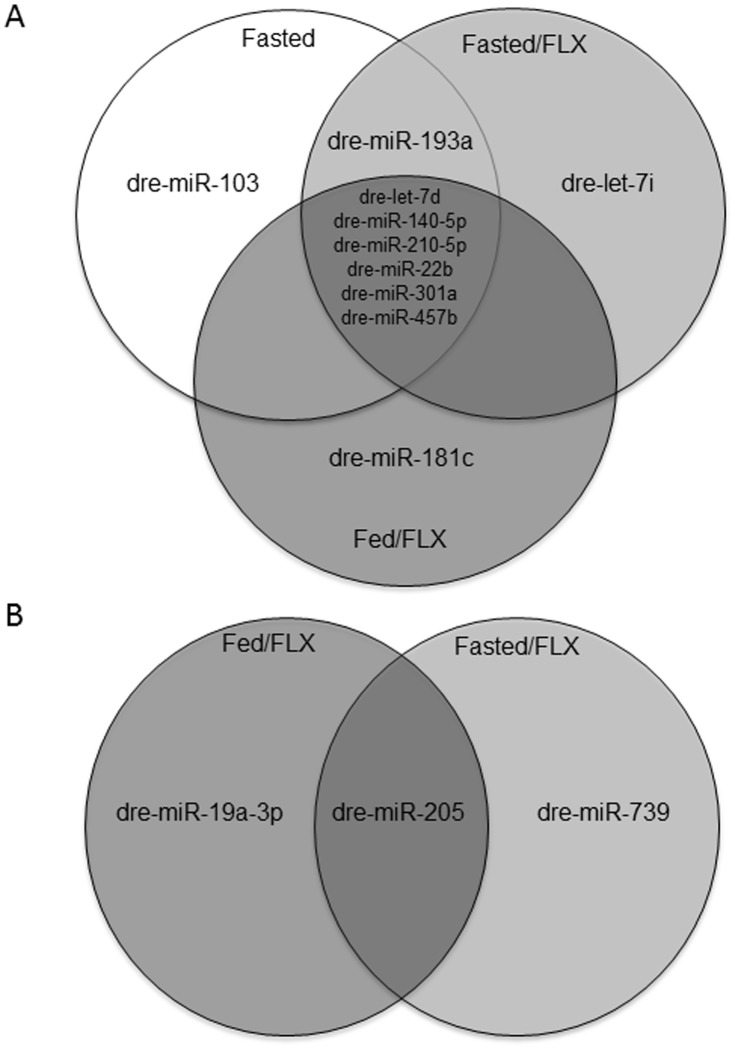
Venn diagrams of the overlapping expression patterns of miRNAs that were (A) up- and (B) down-regulated during fasting (Fasted), fasting with exposure to fluoxetine (540 ng/L; Fasted/FLX), and fed with exposure to fluoxetine (540 ng/L; Fed/FLX).